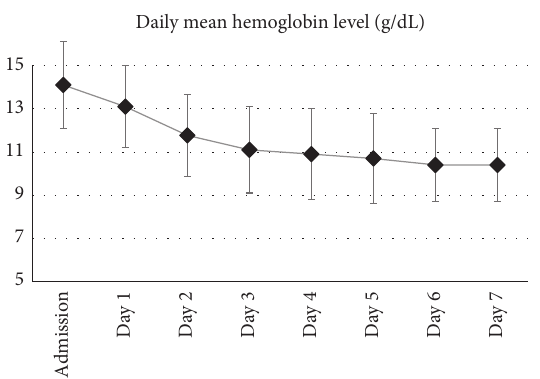
Figure 1: Course of hemoglobin in the first seven days of stay in the intensive care unit for patients with isolated traumatic brain injury. The error bars represent the standard